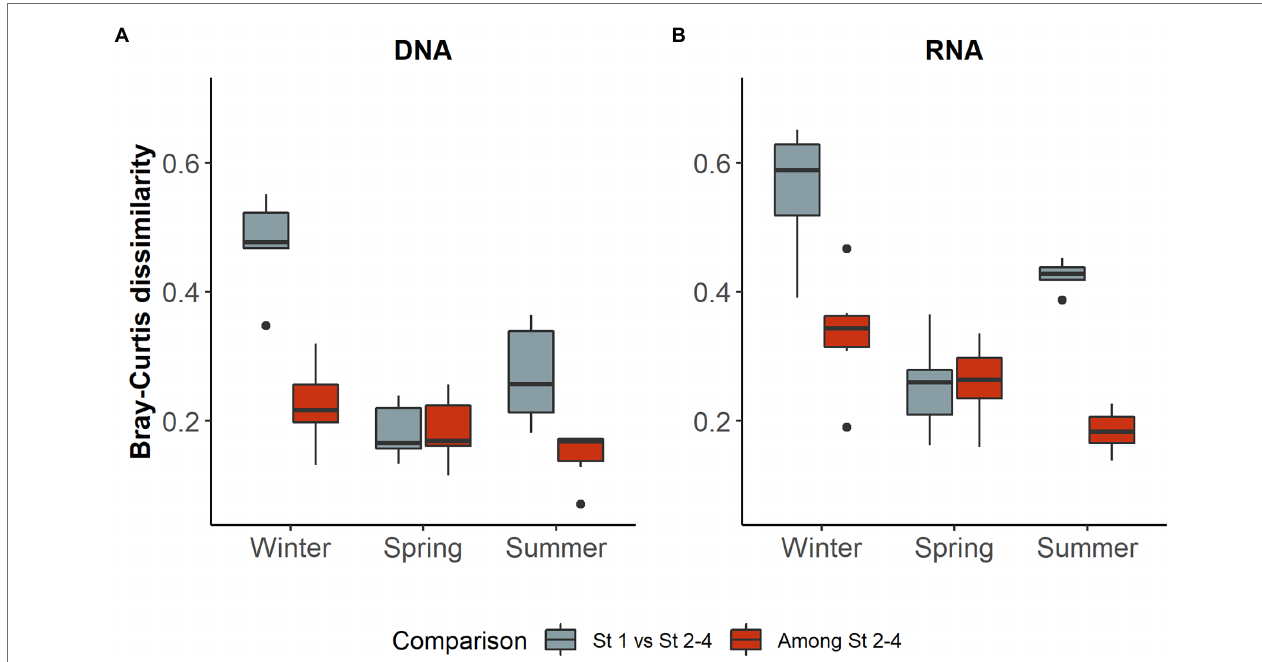
FIGURE 4 | Bray–Curtis dissimilarity in different seasons of (A) DNA and (B) RNA samples in comparisons including and excluding station 1. Only dissimilarities between stations from the same cruise were used. In both sample types, comparisons involving station 1 differed significantly from those among the other stations in early winter and summer (Mann–Whitney U test, two-tailed, winter: RNA z = 2.6421, p < 0.005; DNA: z = 2.8022 p < 0.005; summer: RNA z = − 2.8022, p < 0.005; DNA: z = − 2.8022, p < 0.005), but not in spring (RNA: z = − 0.080064, p = 0.937; DNA: z = 0.24019, p =